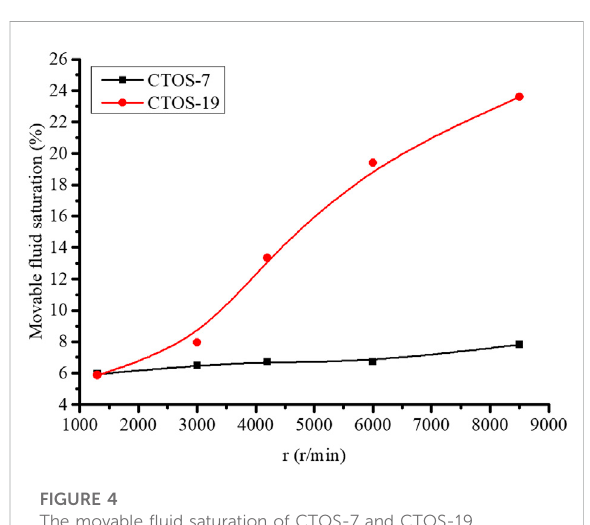
FIGURE 4 The movable fl uid saturation of CTOS-7 and CTOS-19 samples under various centrifugal